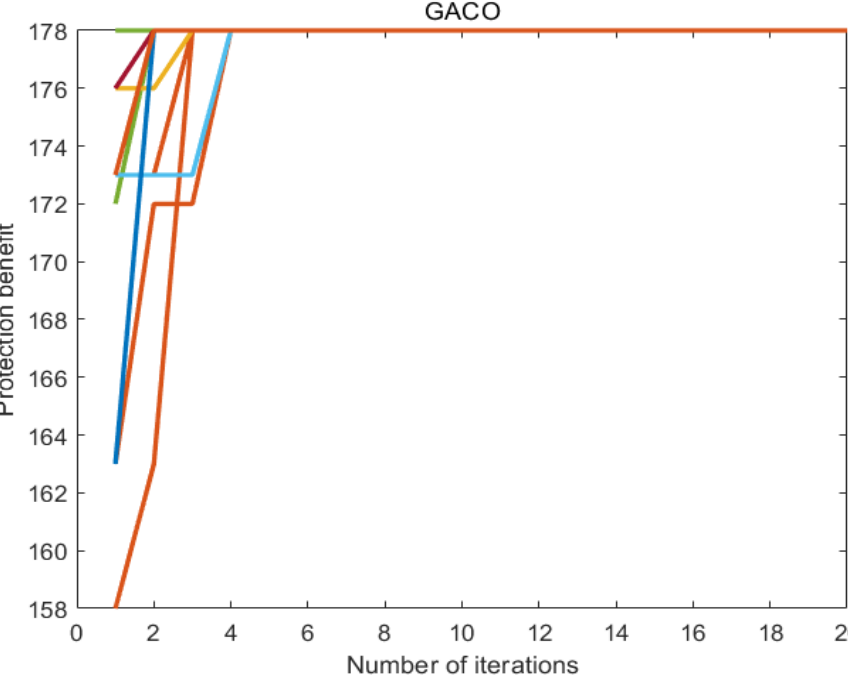
Figure 14. Population size is 100, and the GACO algorithm is run 100